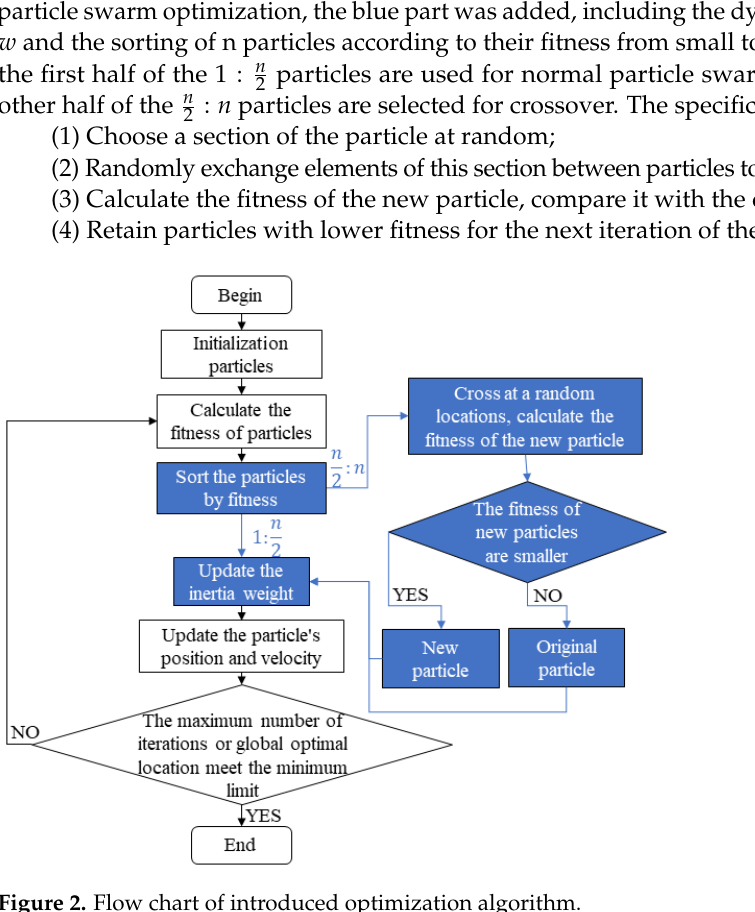
Figure 2. Flow chart of introduced optimization